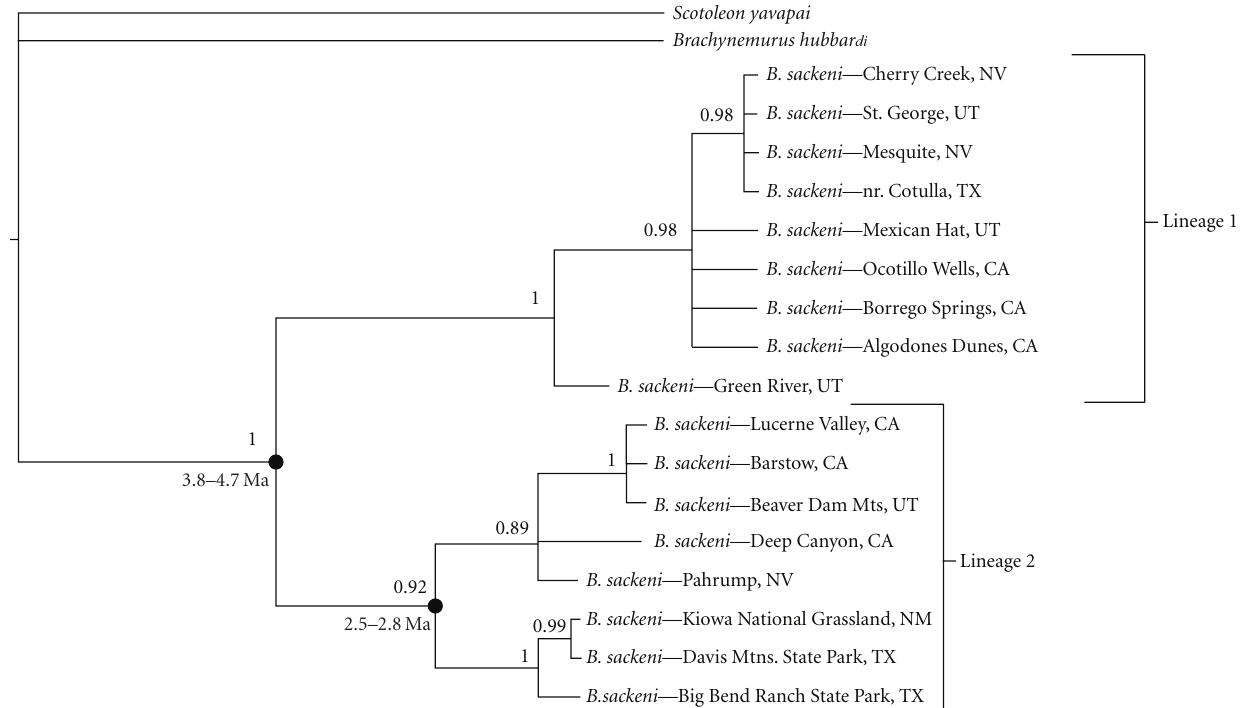
Figure 3: Consensus tree of the Bayesian analysis done on the aligned COI data set. Numbers at each node represent posterior probabilities. Collection locations for each B. sackeni specimen are given. Estimated divergence dates are given for two nodes marked with black